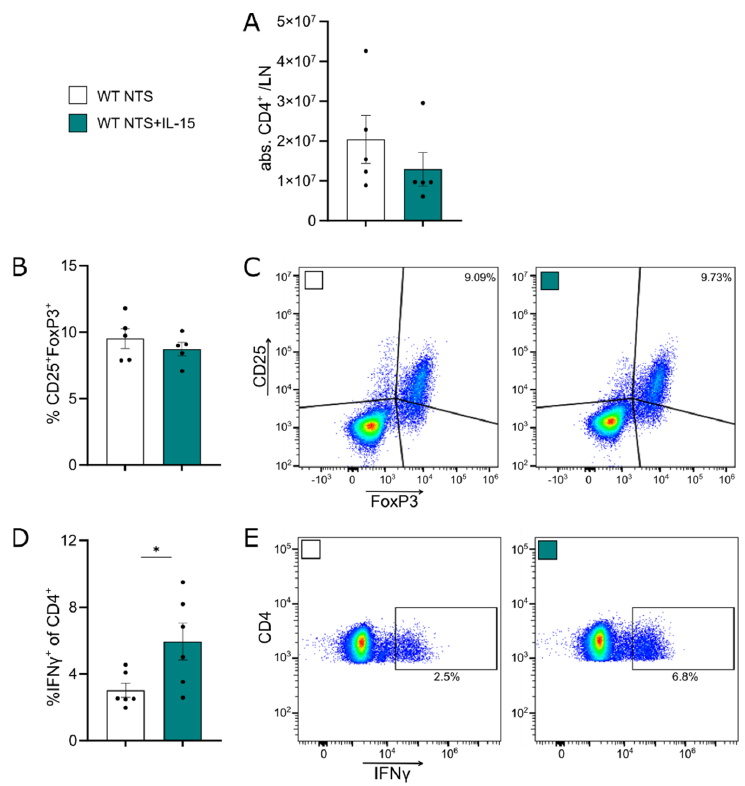
Figure 4. rIL-15 increases IFN γ production of CD4 T cells. Data represent day 7 of NTS. ( A ) Quan- tification of CD4 + T cells and ( B ) frequencies and ( C ) representative plots of CD25 + Foxp3 + T cells in the lymph node. Flow cytometry analysis of frequencies of ( D ) IFN γ + cells of CD4 + T cells and ( E ) representative plots of splenocytes after 4 days of culture. Data in D represent two independent experiments. Black dots represent individual values of respective mice. * p ≤ 0.05. Statistical analysis used was Student’s t -test or Mann–Whitney test. All data are mean ± SEM. 3.5. rIL-15-Mediated Protection of TECs from Cell Death Is Dependent on CD8 + Cells Since low-dose rIL-15 altered CD8 + T cells towards a less cytotoxic phenotype, we aimed to evaluate whether CD8 + T cells themselves are involved in the protective mecha- nism seen in NTS by subjecting CD8 α − / − mice to NTS with or without rIL-15 treatment (Experimental setup Figure 5A). CD8 α − / − mice subjected to NTS and treated with rIL-15 showed higher albuminuria (Figure 5B) and higher PAS scores as compared to CD8 α − / − mice treated with vehicle (Figure 5C,D). Of note, CD8 α − / − mice treated with rIL-15 had comparable levels of circulating mouse anti-rabbit IgG (Figure S2F) and comparable num- bers of iNKT cells in kidney tissue (Figure S2G). In addition, immunohistochemical stain- ing revealed a trend of more Ly6G + cells in glomeruli (Figure 5E) and higher numbers of interstitial Ly6G + cells (Figure 5F) and no difference in numbers of CD68 + cells (Figure 5G) infiltrating the kidney. CD8 α − / − mice with rIL-15 treatment showed a trend of increased tubular cast for- mation 7 days after NTS induction (Figure 5H). TUNEL staining revealed a comparable number of TUNEL + cells in kidney tissues in both groups (Figure 5I). Gene expression profiles of CD8 α − / − mice revealed that in the absence of CD8 + T cells, neither Il-15r α nor Bcl-2 is upregulated on TECs in NTS after rIL-15 administration (Figure 5J).